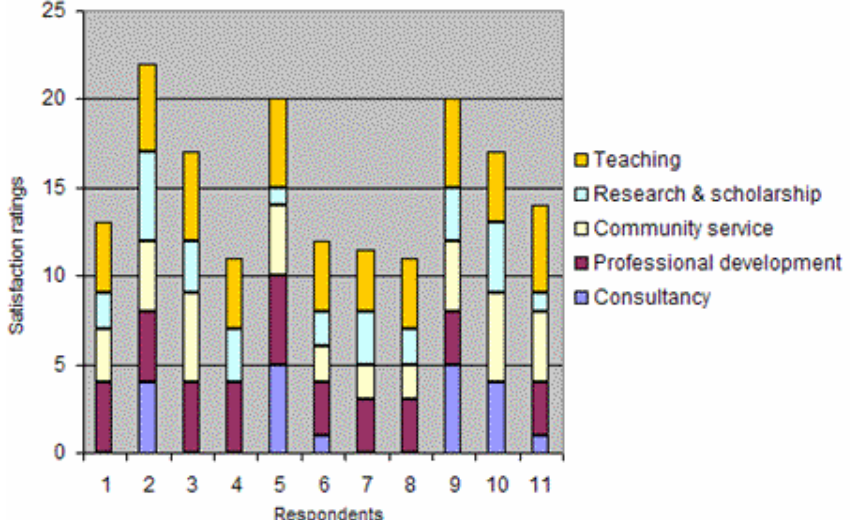
Figure 3. Academic staff job satisfaction ratings in each of the five broad areas of responsibility, Faculty or Rural Management, The University of Sydney,